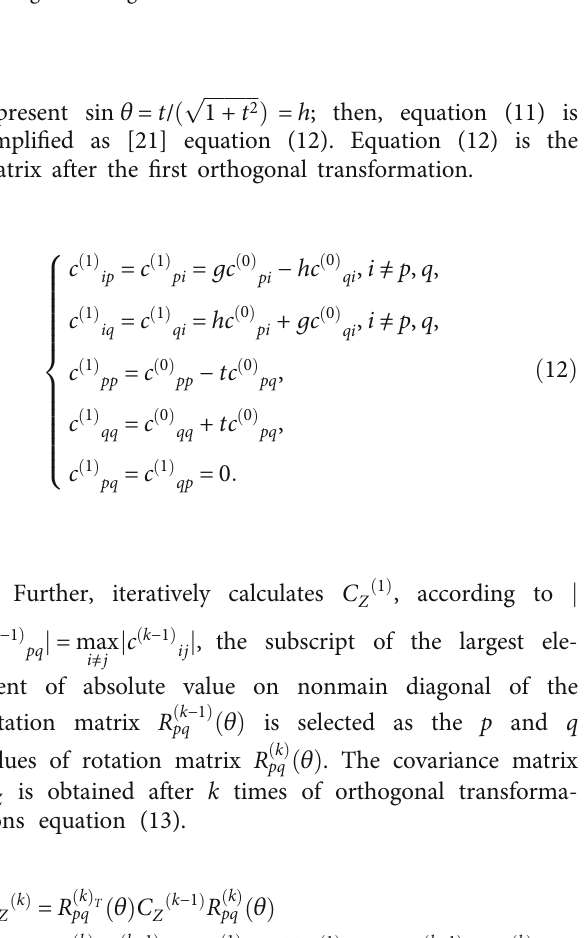
Figure 3: Moving average fi ltering e ff ect